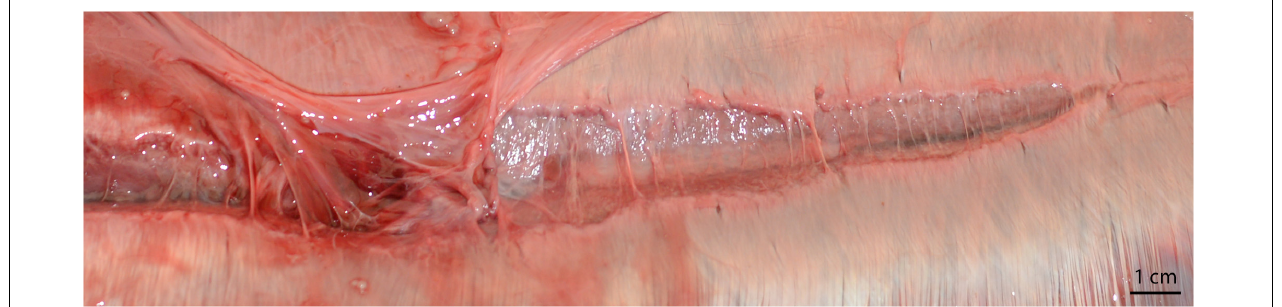
FIGURE 3 | Rectus abdominis separation in a bycaught bottlenose dolphin. Intact superficial midline and irregular margins are consistent with tearing due to tension, rather than incision. Note the hemorrhagic edema present on the left of the image (cranial aspect), the remnant tendinous fibers bridging the wound, the lack of healing wound bridging fibers, and the presence of emissary